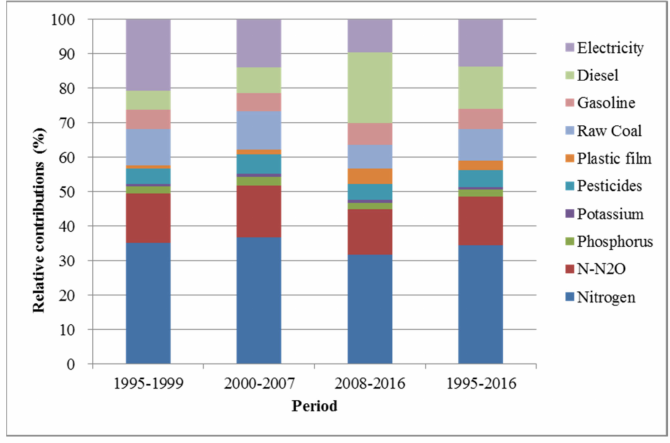
Figure 4. Relative carbon footprint (CF) contributions of 10 emission sources to the